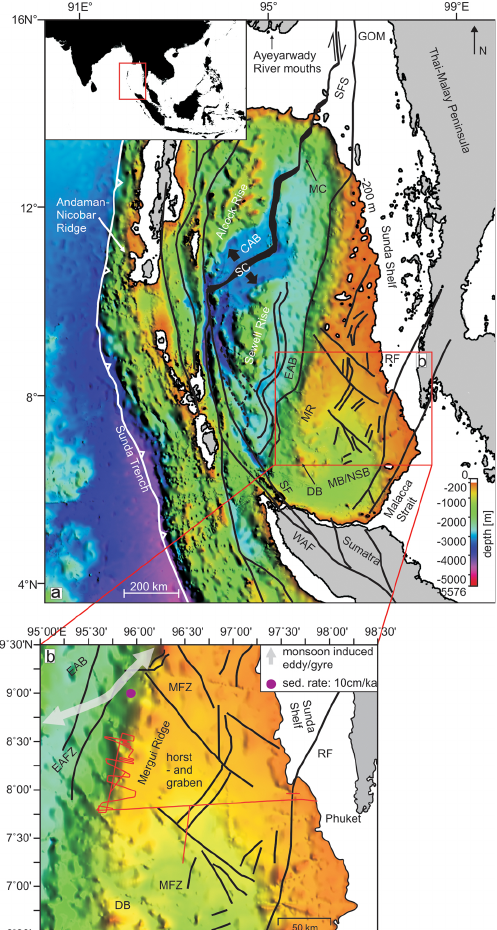
Fig. 1. (a) Bathymetric map and structural framework of the An- daman Sea area. The structural elements are modified from Cur- ray (2005). Black continuous lines mark fault traces of the main fault systems: SFS: Sagaing Fault System; WAF: West Andaman Fault; RF: Ranong Fault; SF: Sumatra Fault System; GOM: Gulf of Martaban; MC: Martaban Canyon; SC: Modern spreading cen- tre; CAB: Central Andaman Basin; EAB: East Andaman Basin; MR: Mergui Ridge; MB/NSB: Mergui Basin/North Sumatra Basin; DB: Dreadnought Bank. The bathymetry has been reproduced from GEBCO. (b) Close-up of the working area, situated in the west- ern flank of Mergui Ridge. The red lines mark seismic lines of MASS III cruise. The black lines denote fault systems, modified af- ter Curray (2005), Morley et al. (2011) and Polachan (1988). MFZ: Mergui Fault Zone (modified after Curray, 2005 and Morley et al., 2011. EAFZ: East Andaman Fault Zone (from Polachan, 1988). DB: Dreadnought Bank. EAB: East Andaman Basin. The grey ar- row shows the approximate position of a monsoonal gyre that in- duces currents in deeper parts of the water column (modified after Varkey et al., 1996). The purple dot shows the position of a sedi- ment core discussed by Rodolfo (1969). The bathymetry has been reproduced from SRTM30 PLUS (Becker et al.,